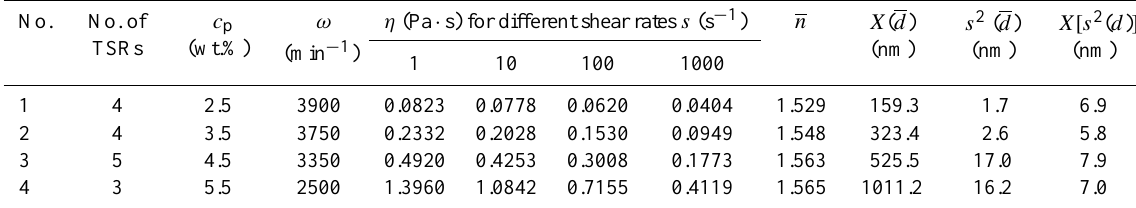
Table 1. Ellipsometry measurements of PVA/PAA films with different coating parameters.